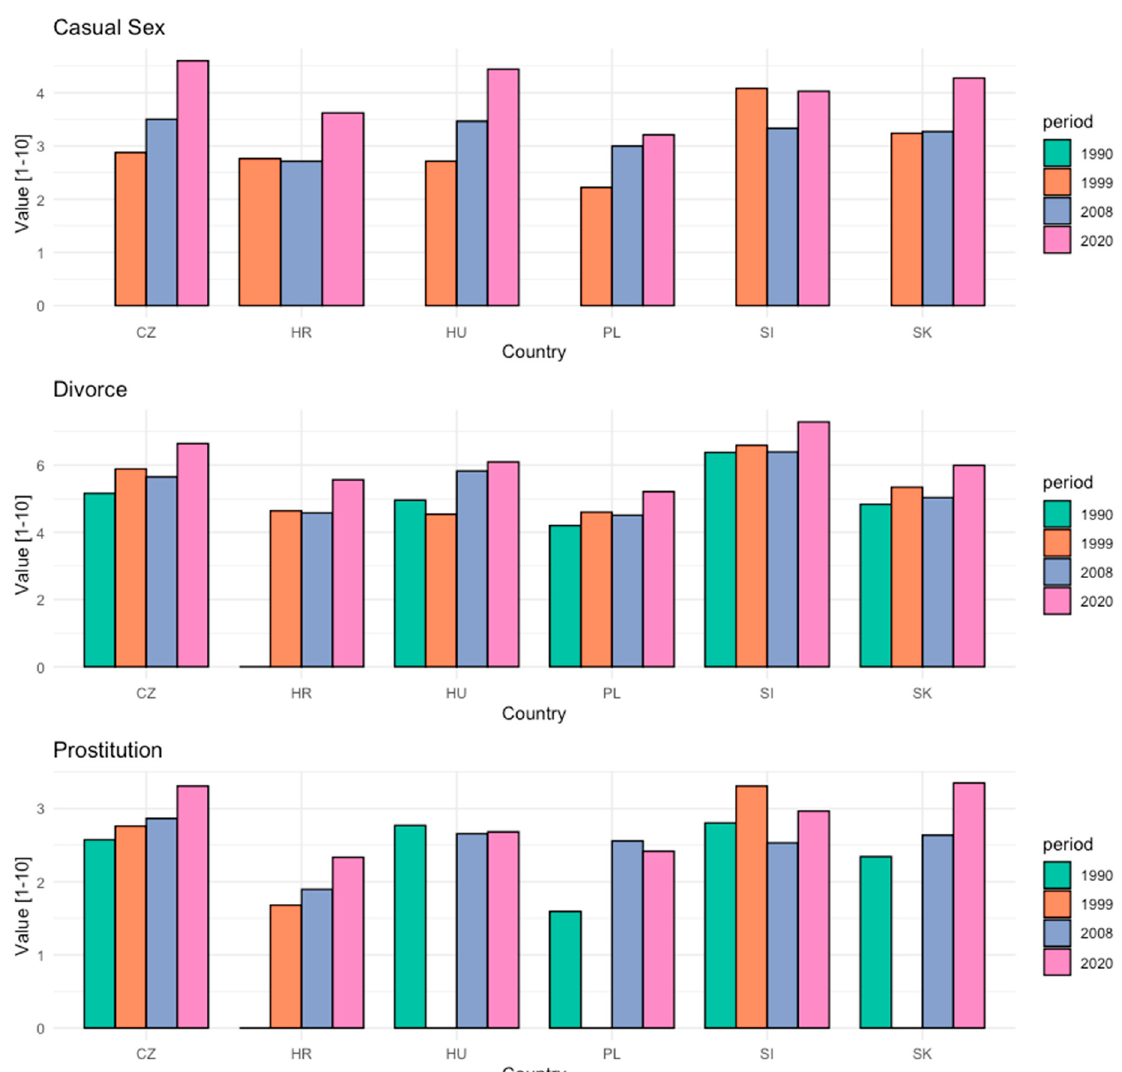
Figure A3. Casual sex, Divorce and Prostitution variables (EVS).